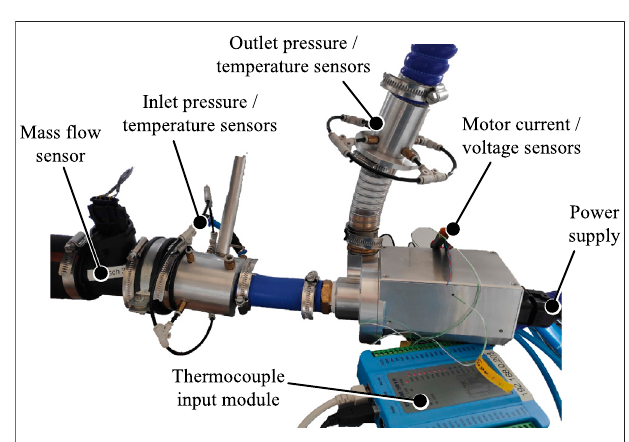
FIGURE 9 | Compressor with an integrated inverter installed in test bench